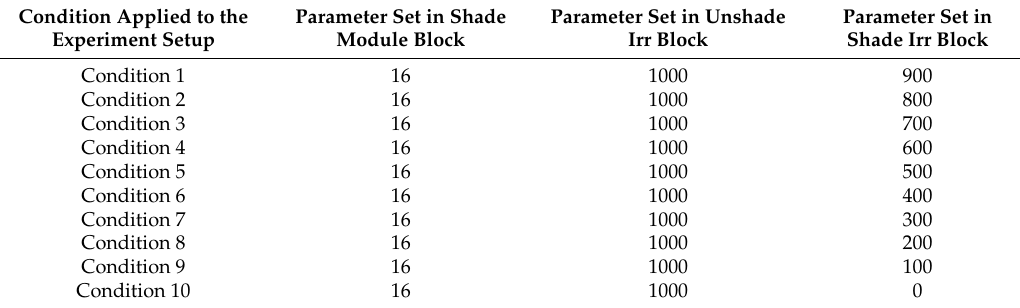
shaded setup. Table 5. Parameters set in the model shown in Figure 7 to conduct the experiment for the 16 modules